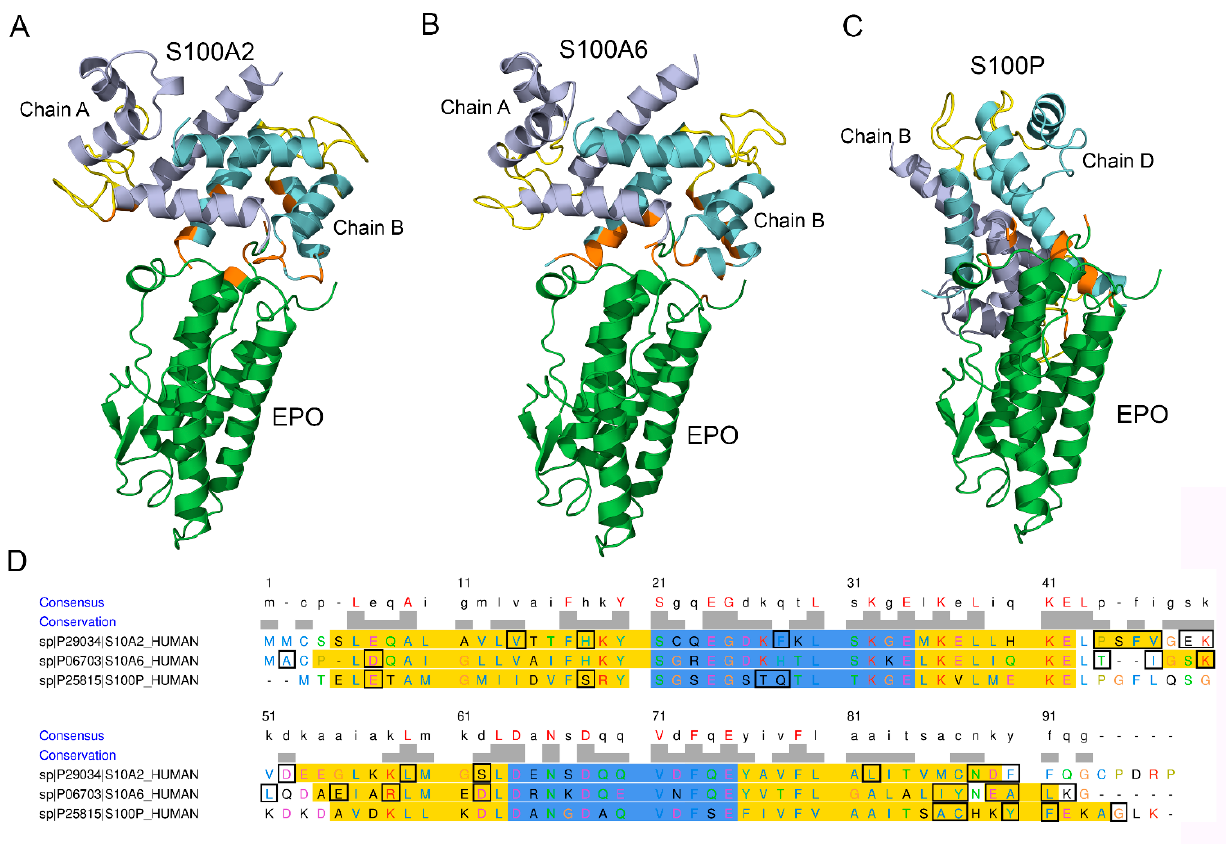
Figure 2. Panels ( A – C ) the models of tertiary structures of EPO (shown in green) complexes with the Ca 2+ -bound S100A2/A6/P dimers. Structures of EPO and the S100A2/A6/P proteins (PDB entries 1BUY, 4DUQ, 1K9K and 2MJW, respectively) are used for the modelling by the ClusPro docking server [49] . The Ca 2+ -binding loops are shown in yellow. The contact residues are orange-colored. Panel ( D ) mapping of the contact residues of the S100A2/A6/P proteins (shown in rectangles) onto their aligned amino acid sequence (MUSCLE algorithm as implemented in EMBL-EBI service [59]). The Ca 2+ -binding loops and helical regions according to the PDB entries are marked in blue and yellow, respectively. The residue letters are colored using the Clustal X color scheme. The scheme is prepared using the UCSF Chimera molecular modelling system [58] .